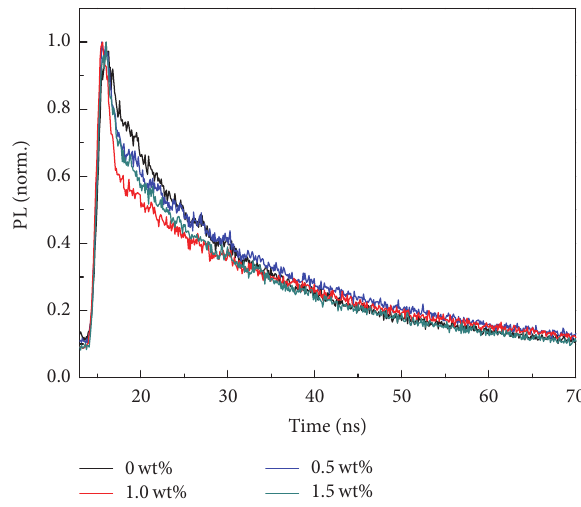
Figure 8: Normalized transient PL decay profiles of the perovskites based on TiO 2 with different wt% PS.